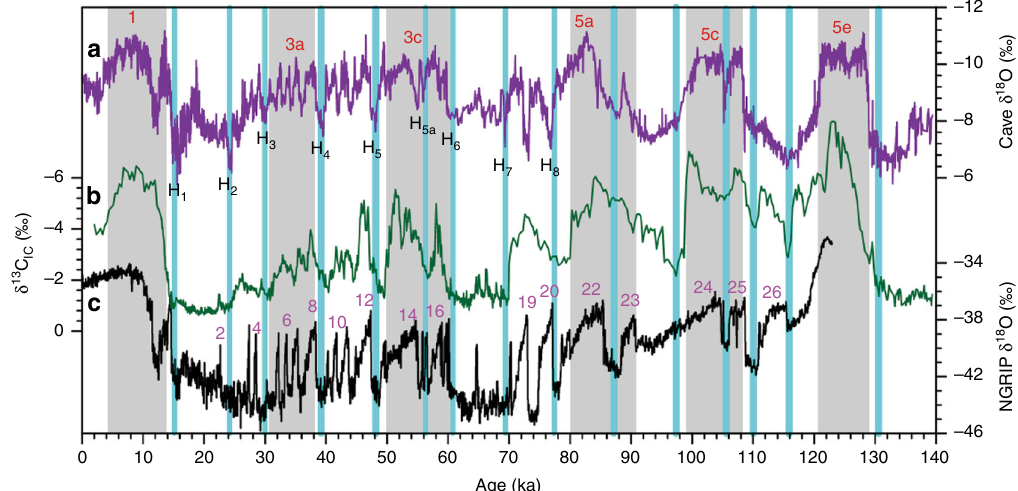
Fig. 5 Proxy variations over the last 140 ka from Greenland ice core, Chinese loess, and speleothem. a Chinese spleothem δ 18 O record 15 . b JY loess δ 13 C IC . c Greenland ice-core δ 18 O record 53 . Dashed lines denote correlations of positive loess δ 13 C IC and speleothem δ 18 O with low Greenland